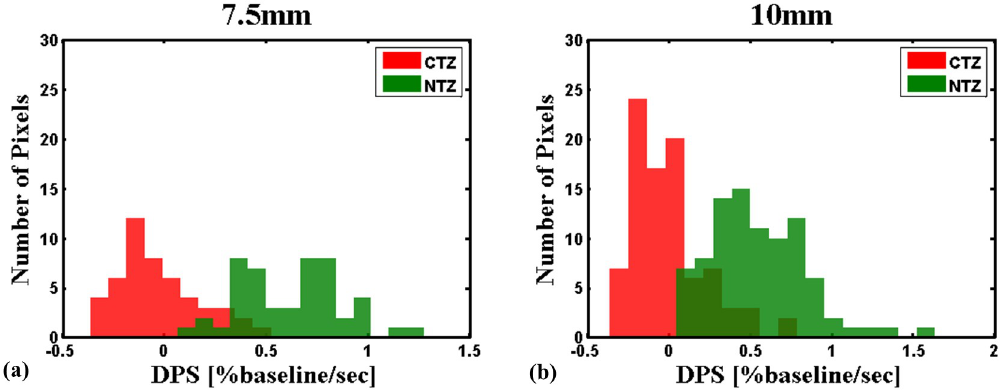
Fig 3. Comparison of the ROC curves of histogram parameters in the differentiation of tumors with maximum difference wash-in and delay phase slopes. The parameters of the MWS (red lines) and those of the DPS (blue lines) in (a) the transitional zone and (b) the peripheral zone. Note the AUC of the parameters of the DPS (blue lines) are generally larger than those of the MWS (red lines) in (a), while contrary in (b).